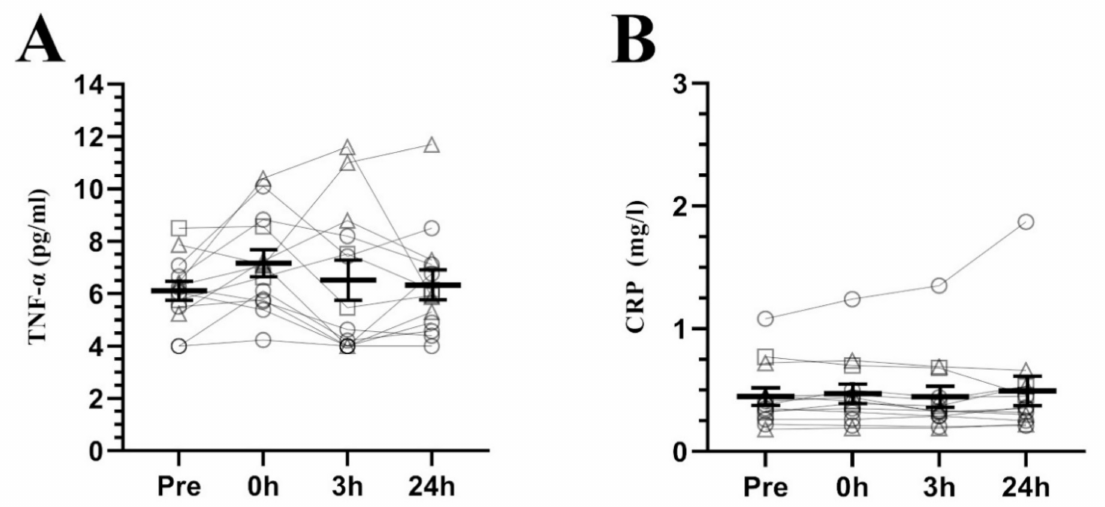
Figure 2. Serum TNF- α ( A ) and CRP ( B ) concentrations at baseline and its response to a high-intensity interval running session (mean ± SEM). Pre, pre-exercise; 0 h, 0 h post-exercise; 3 h, 3 h post-exercise; 24 h, 24 h post-exercise; TNF- α , Tumor necrosis factor alpha; CRP, C-reactive protein. Circles = participants with non-depleted ferritin stores ( ≥ 30 ng / mL), Squares = participants with high estrogen concentrations ( > 100 pg / mL) and non-depleted ferritin stores ( ≥ 30 ng / mL), Triangles = participants with depleted ferritin stores ( < 30 ng /